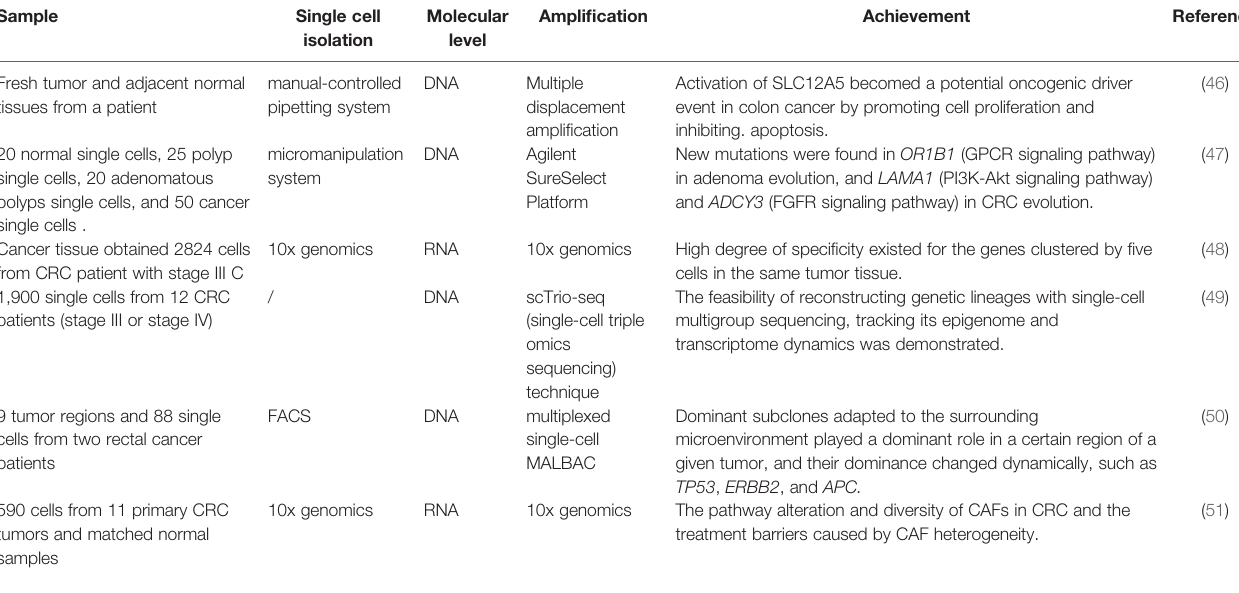
TABLE 7 | SCS in colorectal cancer Heterogeneity. Sample